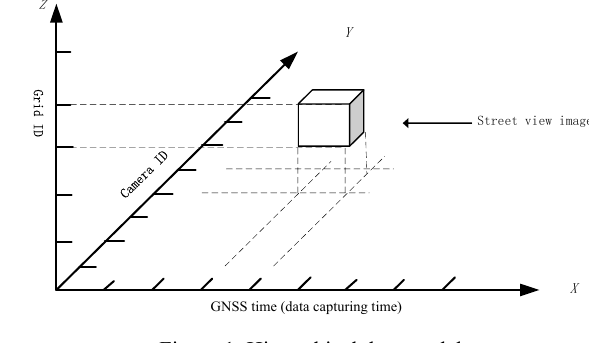
Figure 1. Hierarchical data model